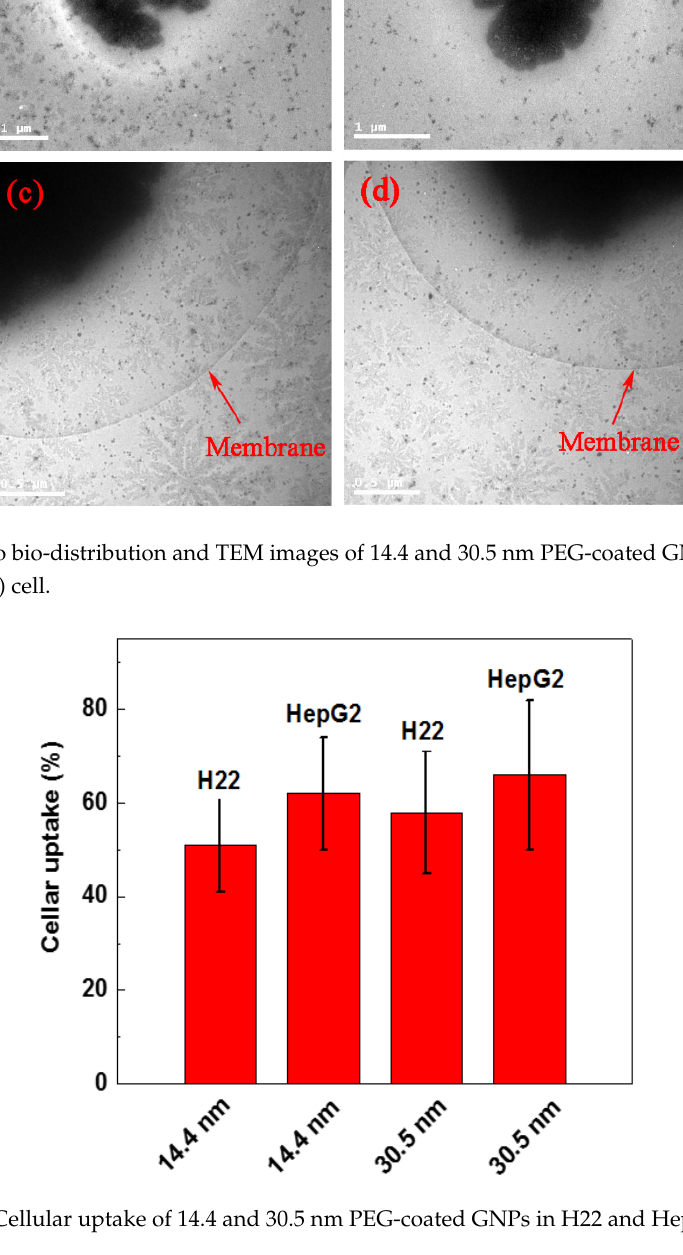
Figure 5. Cellular uptake of 14.4 and 30.5 nm PEG-coated GNPs in H22 and HepG2 cells.